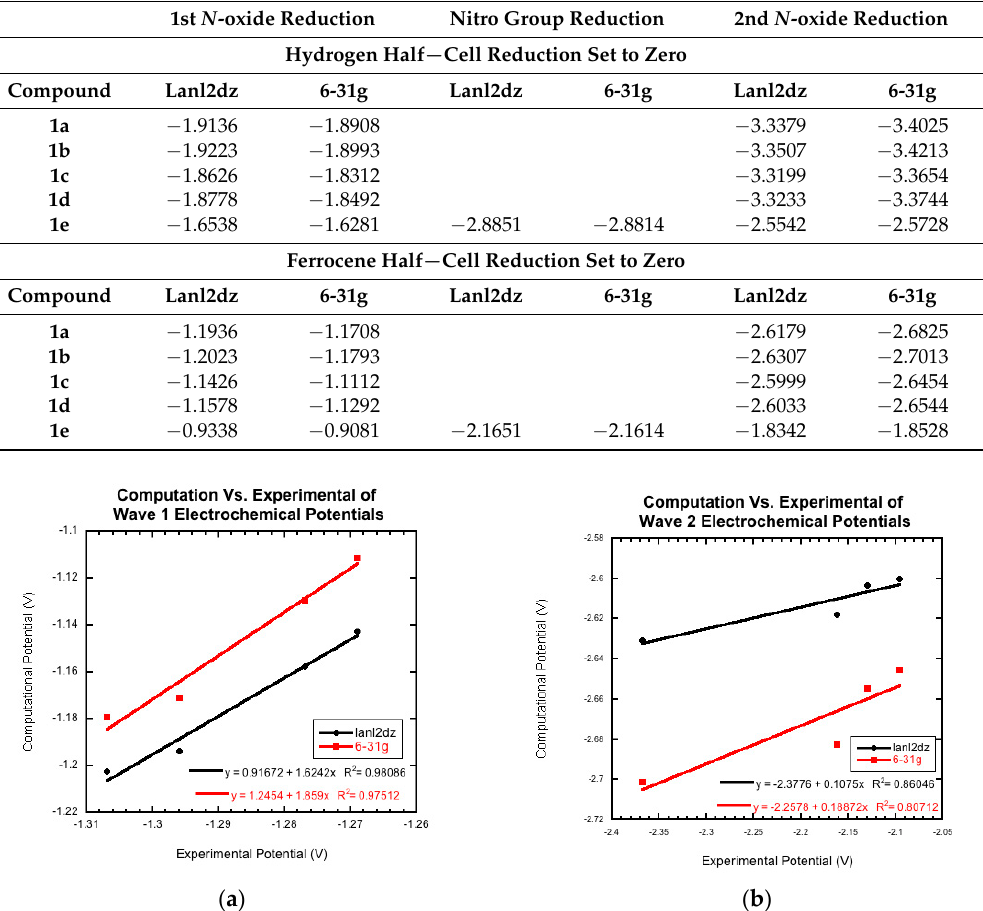
Table 5. The reduction potentials in volts for the 1st N -oxide, nitro group and 2nd N -oxide reductions versus ferrocene, calculated using the lanl2dz and 6-31g basis sets in Gausian 09. 1st N -oxide Reduction Nitro Group Reduction 2nd N -oxide Reduction